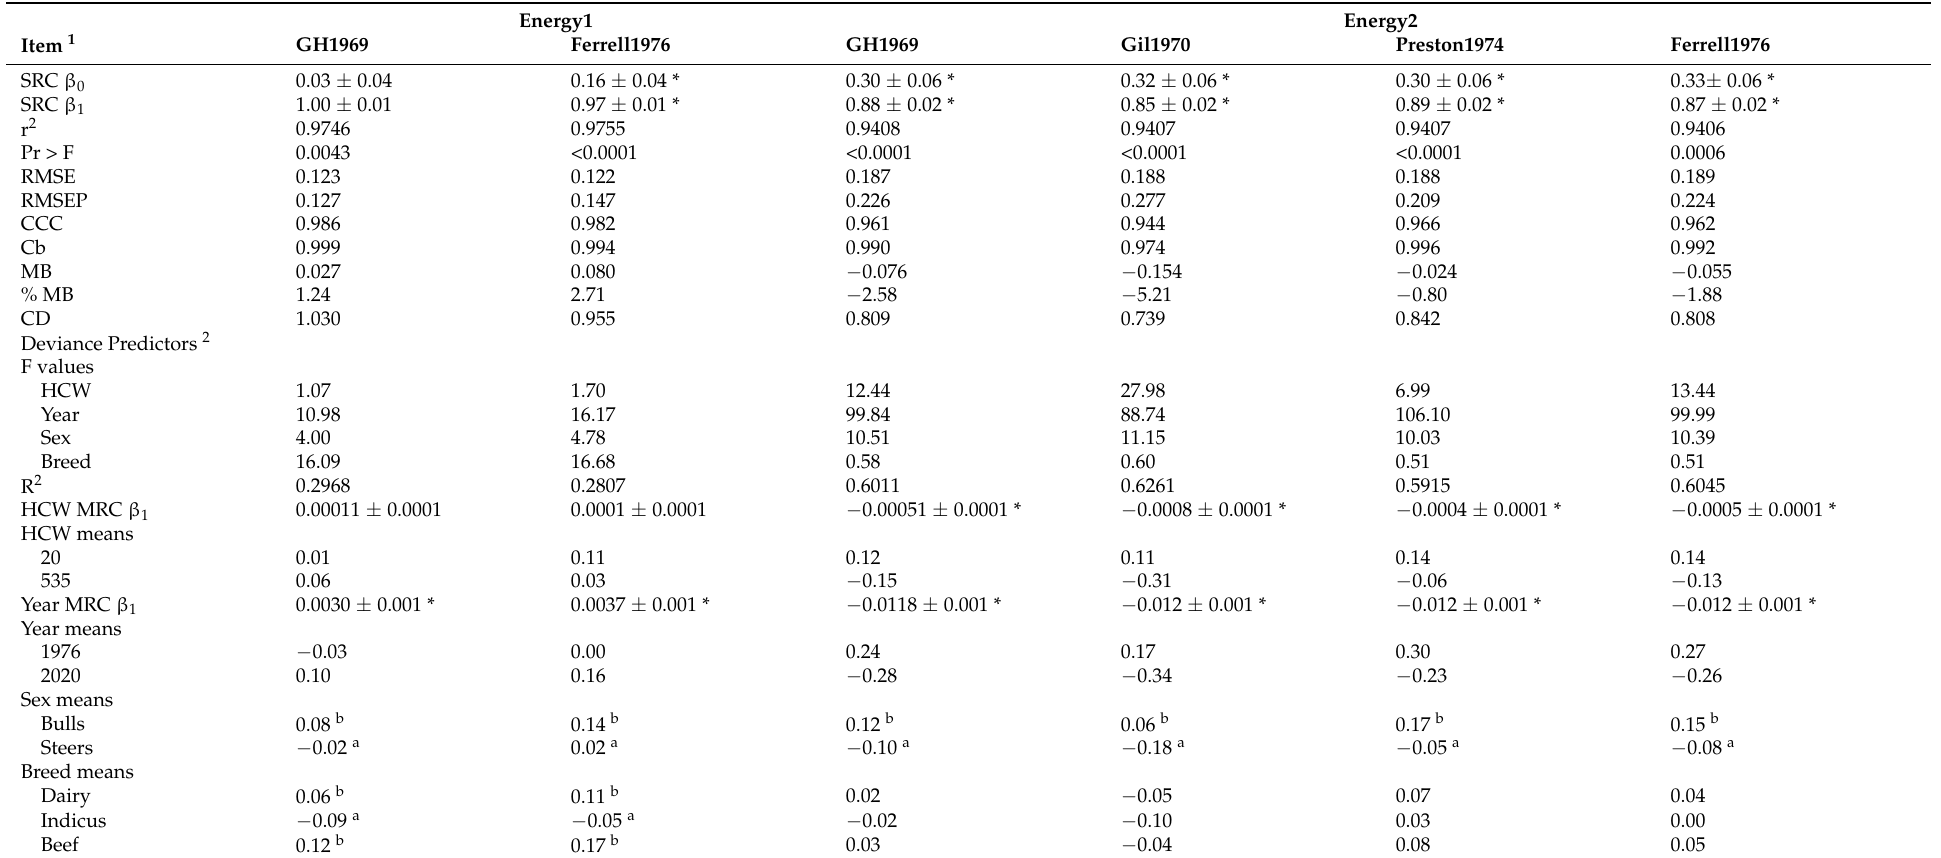
Table 11. Model evaluation of predicting carcass energy content assuming carcass water is known, and predictive variables of the deviance between observed and predicted carcass chemical components in the Carcass